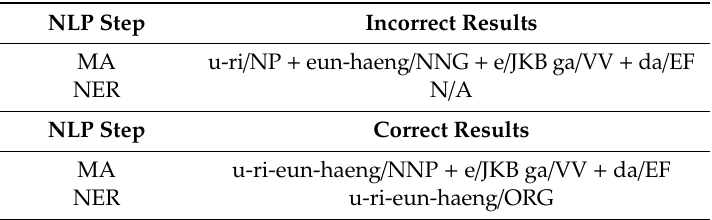
Table 1. Example of Korean named entities a ff ected by morphological analysis (MA) results (NP, NNG, JKB, VV, and EF are Korean part-of-speech (POS) tags, and ORG is a Korean named entity (NE)